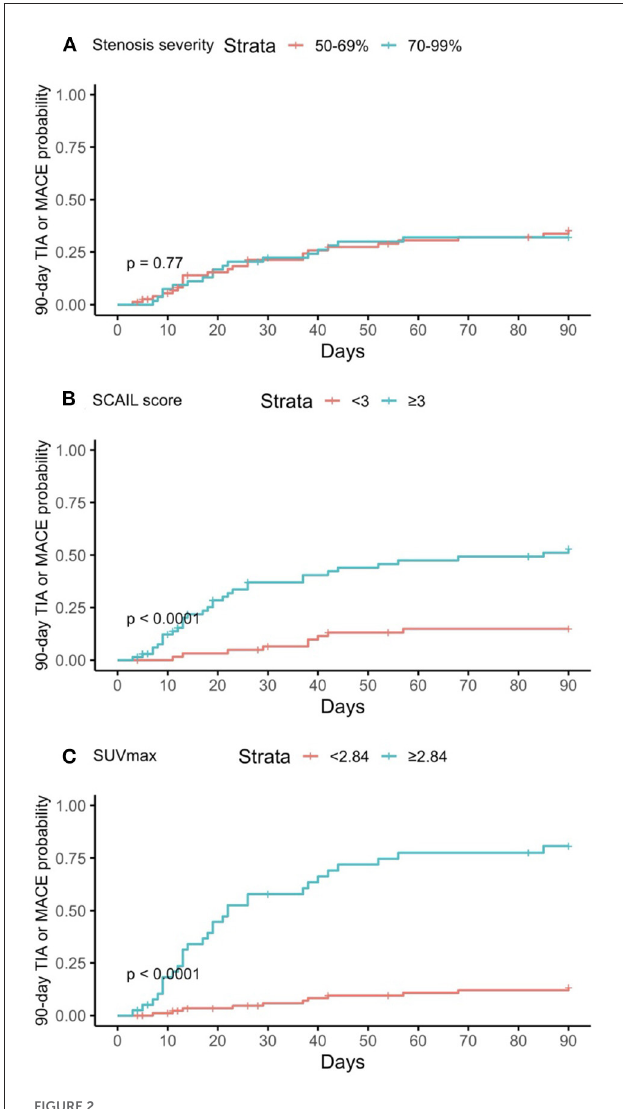
FIGURE2 Kaplan–Meier curves of predictors for 90-day TIA or MACE. (A) Degree of stenosis in symptomatic plaque; (B) Symptomatic plaque SCAIL score; (C) Symptomatic plaque SUVmax. TIA, transient ischemic attack; MACE, major adverse cardiovascular event; SCAIL, symptomatic carotid atheroma inflammation lumen-stenosis; SUVmax, maximum standardized uptake